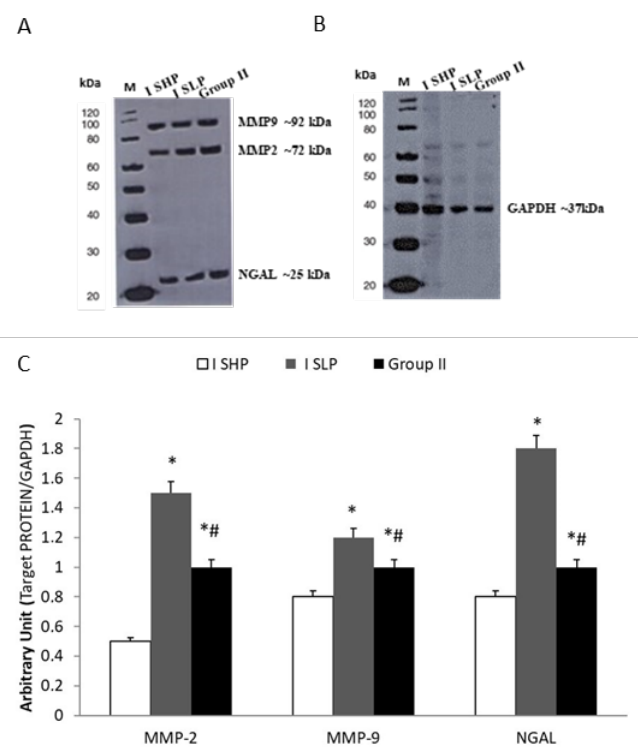
Figure 4. ( A ) Representative tissue levels of MMP-2, MMP-9, and NGAL in aneurysmal tissue. ( B ) GAPDH is used as loading control. ( C ) Tissue expression of MMP2, MMP-9, and NGAL in patients enrolled in Group I and treated with statin high potency (I SHP) (taking rosuvastatin 40 mg / day or atorvastatin 80 mg / day) or statin low potency (I SLP) (taking rosuvastatin < 40 mg / day or atorvastatin < 80 mg / day) and in patients enrolled in Group II (statin-free treatment). The results are expressed as mean ± standard error of the mean (SEM); * p < 0.01 vs. Group I SHP; # p < 0.01 vs. Group I SLP.